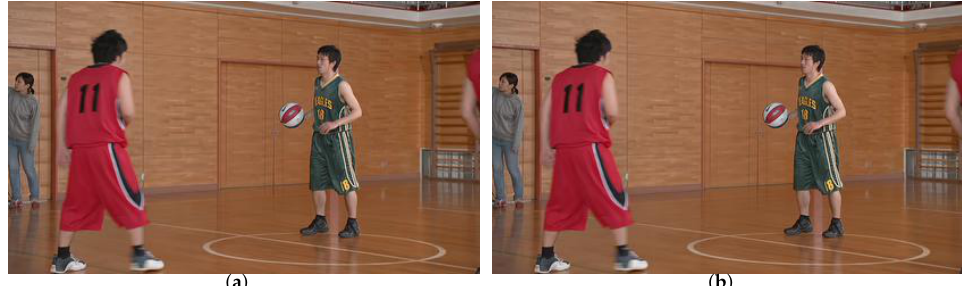
Figure 4. Subjective quality comparison of the first decoding frame of “BasketballPass” from Class D. ( a ) original VVC; ( b ) proposed